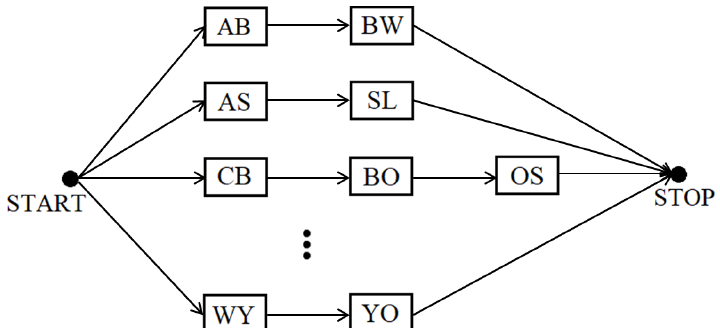
Figure 6. The structure of connected transition models for the method dependent on the acronym dictionary. Every transition model is represented by a rectangular block. For the sake of clarity, only a few of all the blocks and connections are depicted. Table 5. Recognition rates of the method using the acronym dictionary. Feature vector based